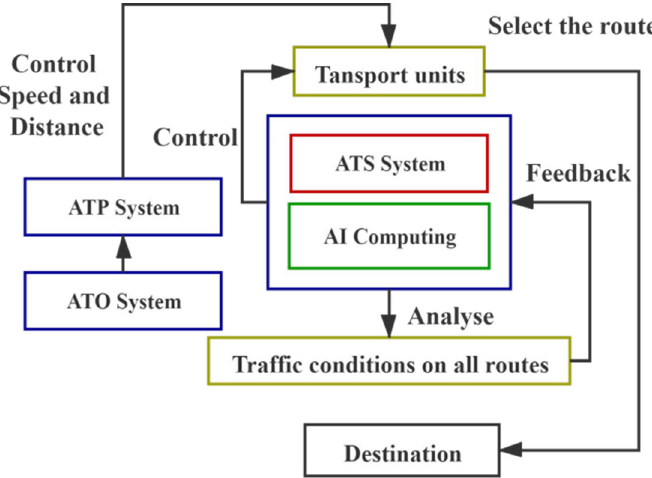
Figure 9. The route adjustment.